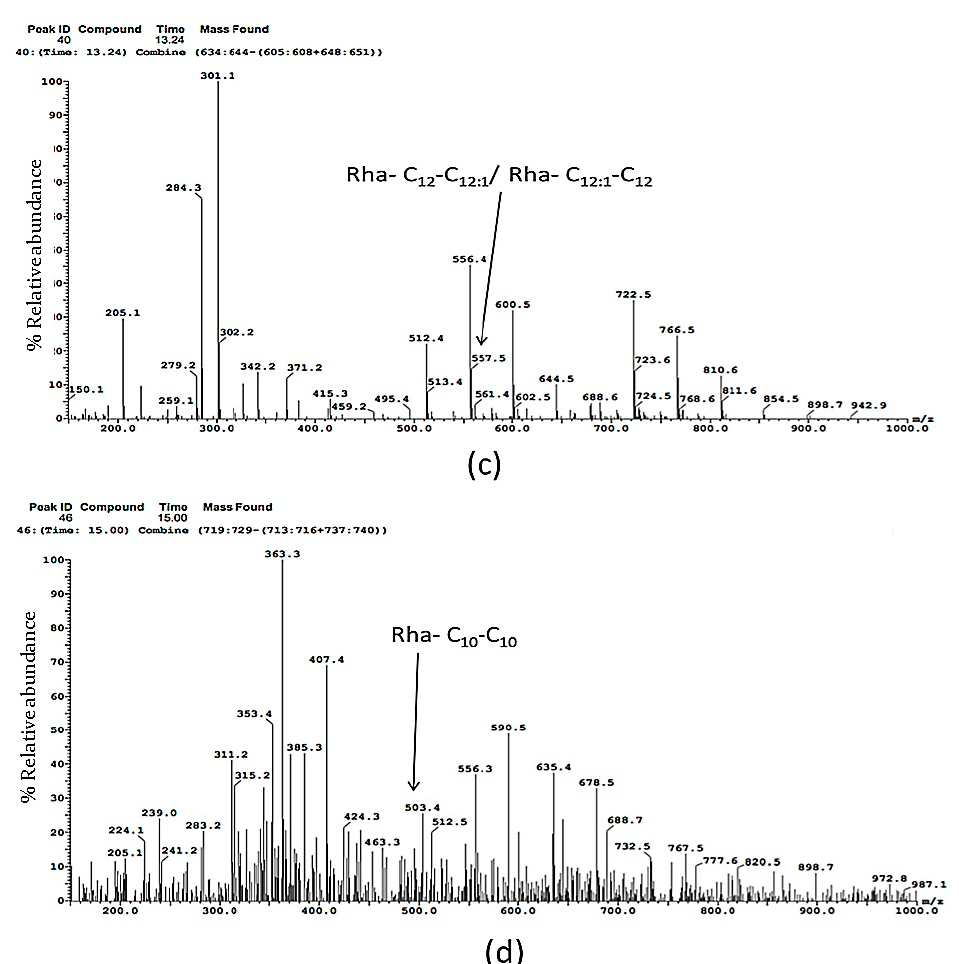
Figure 2. LC-MS analysis of the biosurfactant produced from BSP9 showing specific rhamnose congeners ( a ) peak at m / z 529.3 marked by arrow corresponds to Rha-C 12:1 -C 10 LC-MS ( b ) peaks at m / z 532.3, 576.4 and 621.5 marked by arrows correspond to Rha-C 10 -C 12 /Rha-C 12 -C 10 , Rha-C 10 -C 14:1 /Rha-C 12 -C 12:1 and Rha-Rha-C 8 -C 10 or Rha-Rha-C 10 -C 8 respectively ( c ) peak at m / z 557.8 corresponds to Rha- C 12 -C 12:1 /Rha- C 12:1 -C 12 ( d ) peak at m / z 503.4 corresponds to Rha-C 10 -C 10 .